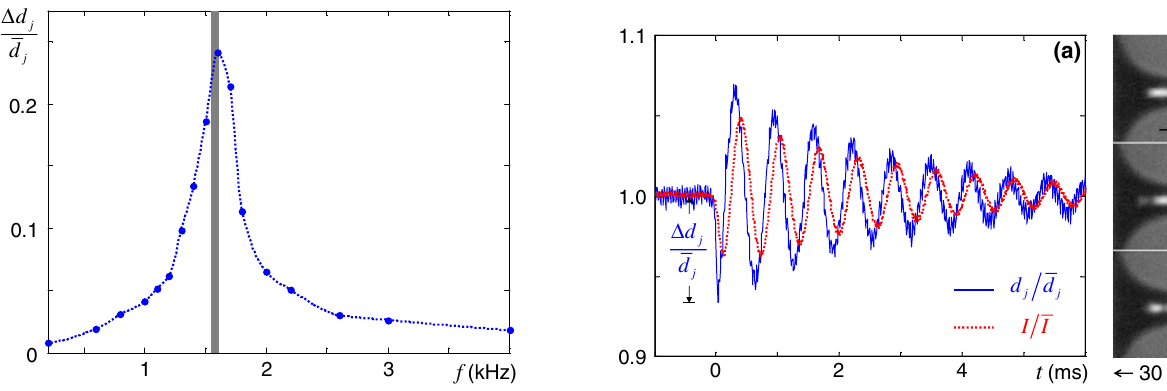
FIG. 5. Particle-triggered oscillations with conditions specified FIG. 4. The resonance of the cone-jet bridge. A sinusoidal in Fig. 4. (a) Synchronized measurements of the diameter ( d j ) voltage with a peak-to-peak amplitude of 20 V was added to the base voltage of 2.4 kV, and the relative change in the jet and current ( I ) of the oscillating jet. Except for a phase shift, (cid:2) d diameter ( (cid:3) d j = these oscillations were perfectly correlated. The impulse re- j ) was recorded at each driving frequency. Other conditions were the same as in Fig. 3. The frequency of sponse up to the first maximum jet diameter was somewhat the particle-triggered oscillation measured in the same system was 1576 (cid:4) 33 Hz (shaded area), coinciding with the measured resonant frequency of 1.6 kHz. The resonant and particle- triggered oscillations were shown at the top and bottom, respec- tively, of Video 2